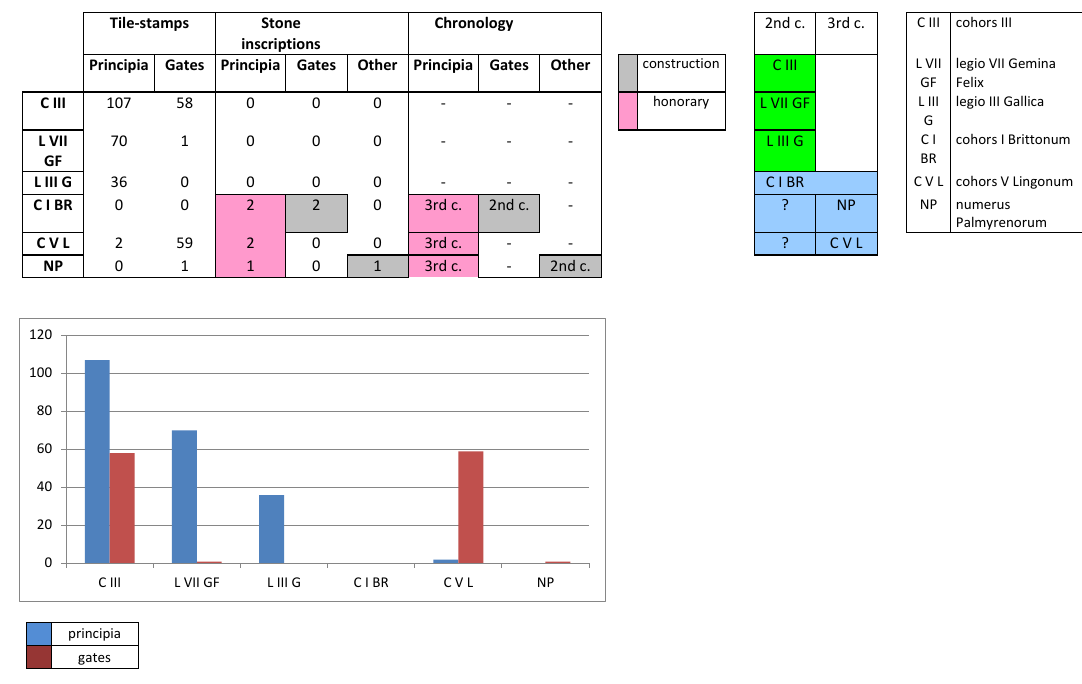
Figure 4. Topographical and chronological correspondence between tile-stamps and honorary and building inscription of the military units recorded in the fort at